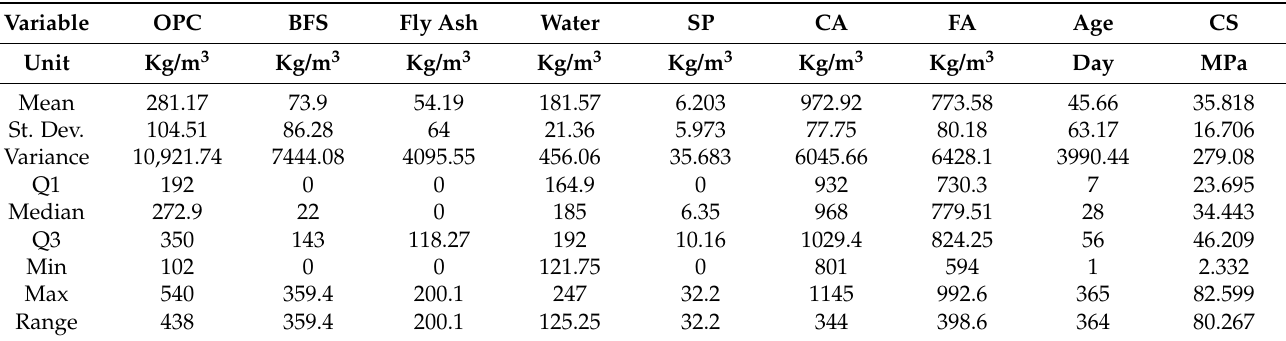
Table 1. Descriptive Statistical Analysis of the